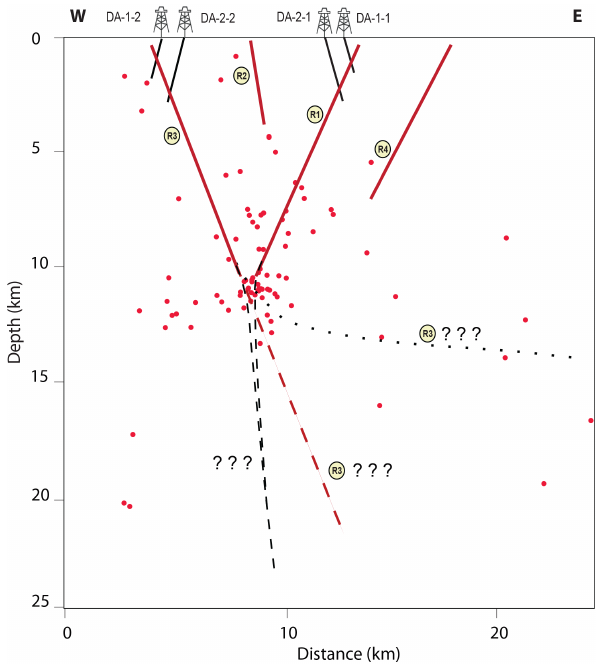
Figure 10. A simplified model of the Pärvie fault system. A larger area compared with Fig. 9 with projected earthquakes (red dots) and the location of some possible boreholes is shown. Below 8km depth, the main fault (R3) may continue at a similar dip (shown by the red dashed line), become listric (marked by the dotted line) or form the lower part of a flower structure (marked by the black dashed lines). During the first phase of the drilling project (DAFNE), boreholes DA-1-1 and DA-1-2 will penetrate the R1 and R3 faults at about 1km depth, respectively. Based on the result of the first phase, one deep borehole (either DA-2-1 or DA-2-2) will be chosen to drill into R1 or R3 at a depth of about